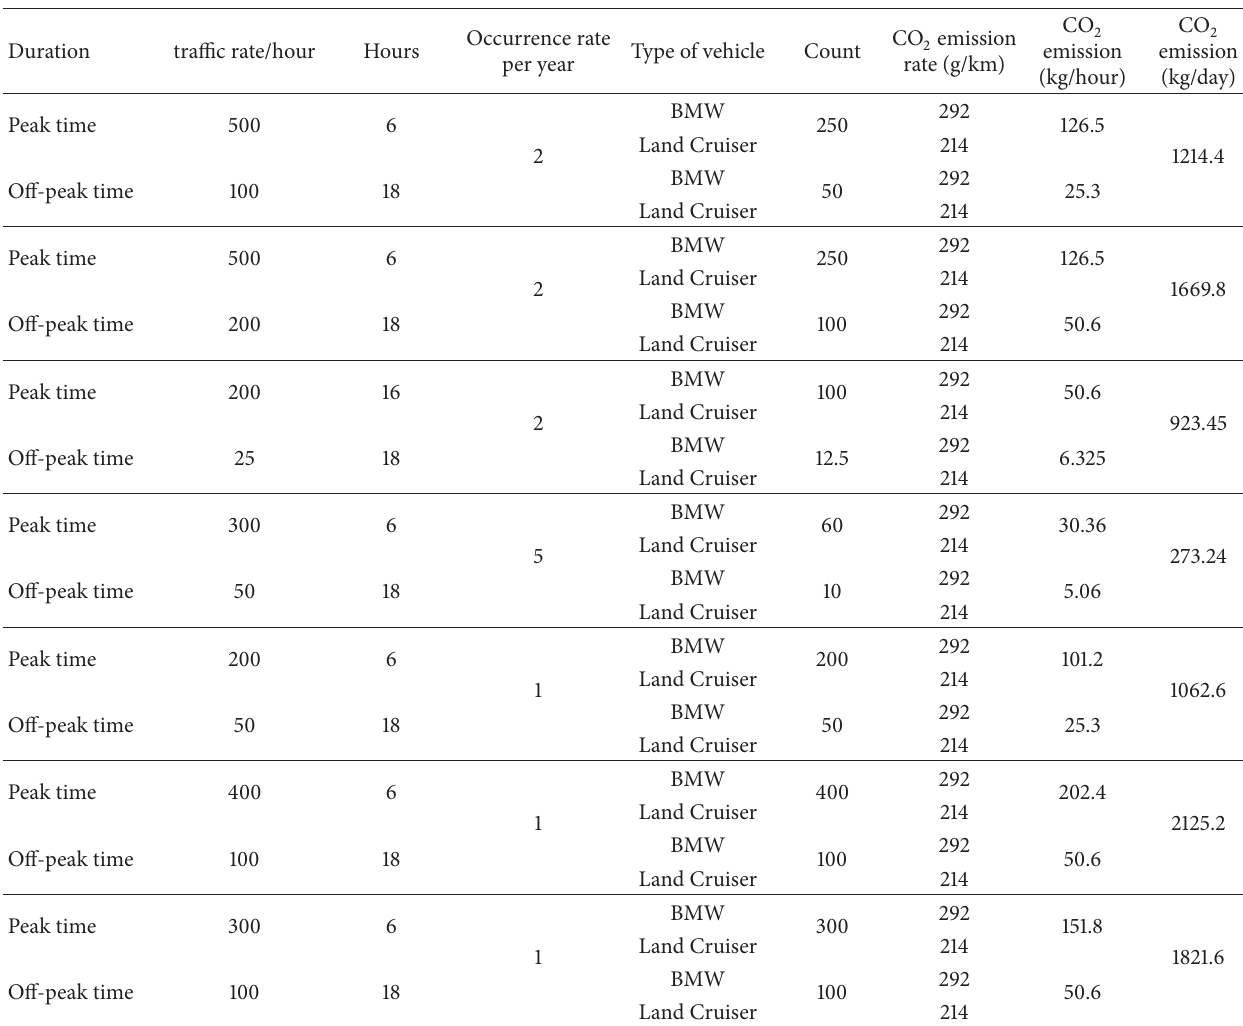
Table 11: Overall carbon